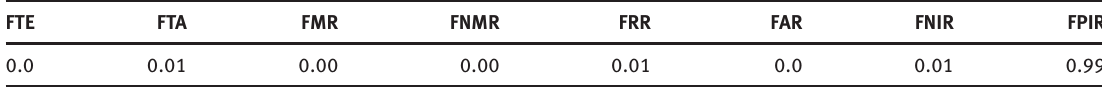
Table 7: Various System Performance